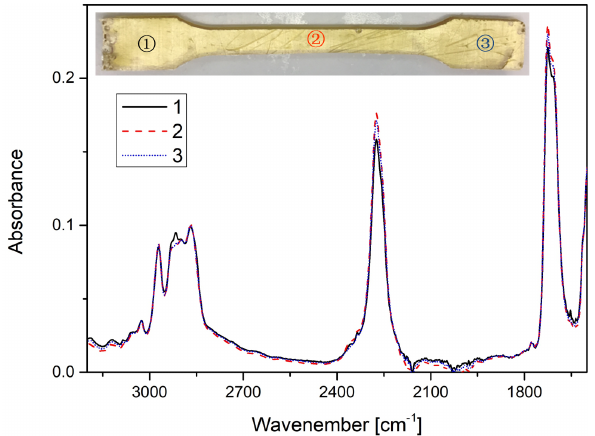
Figure 2: Tensile test specimen and corresponding FTIR spectrum at three different points